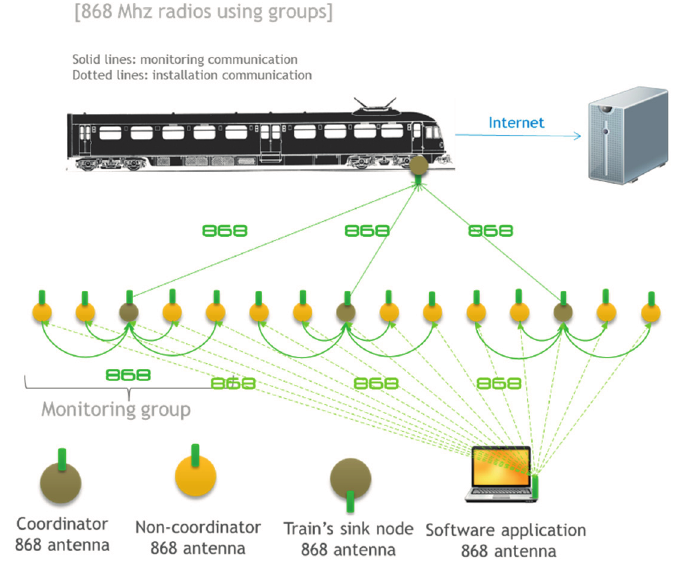
Figure 8. 868 MHz radios using groups: communication